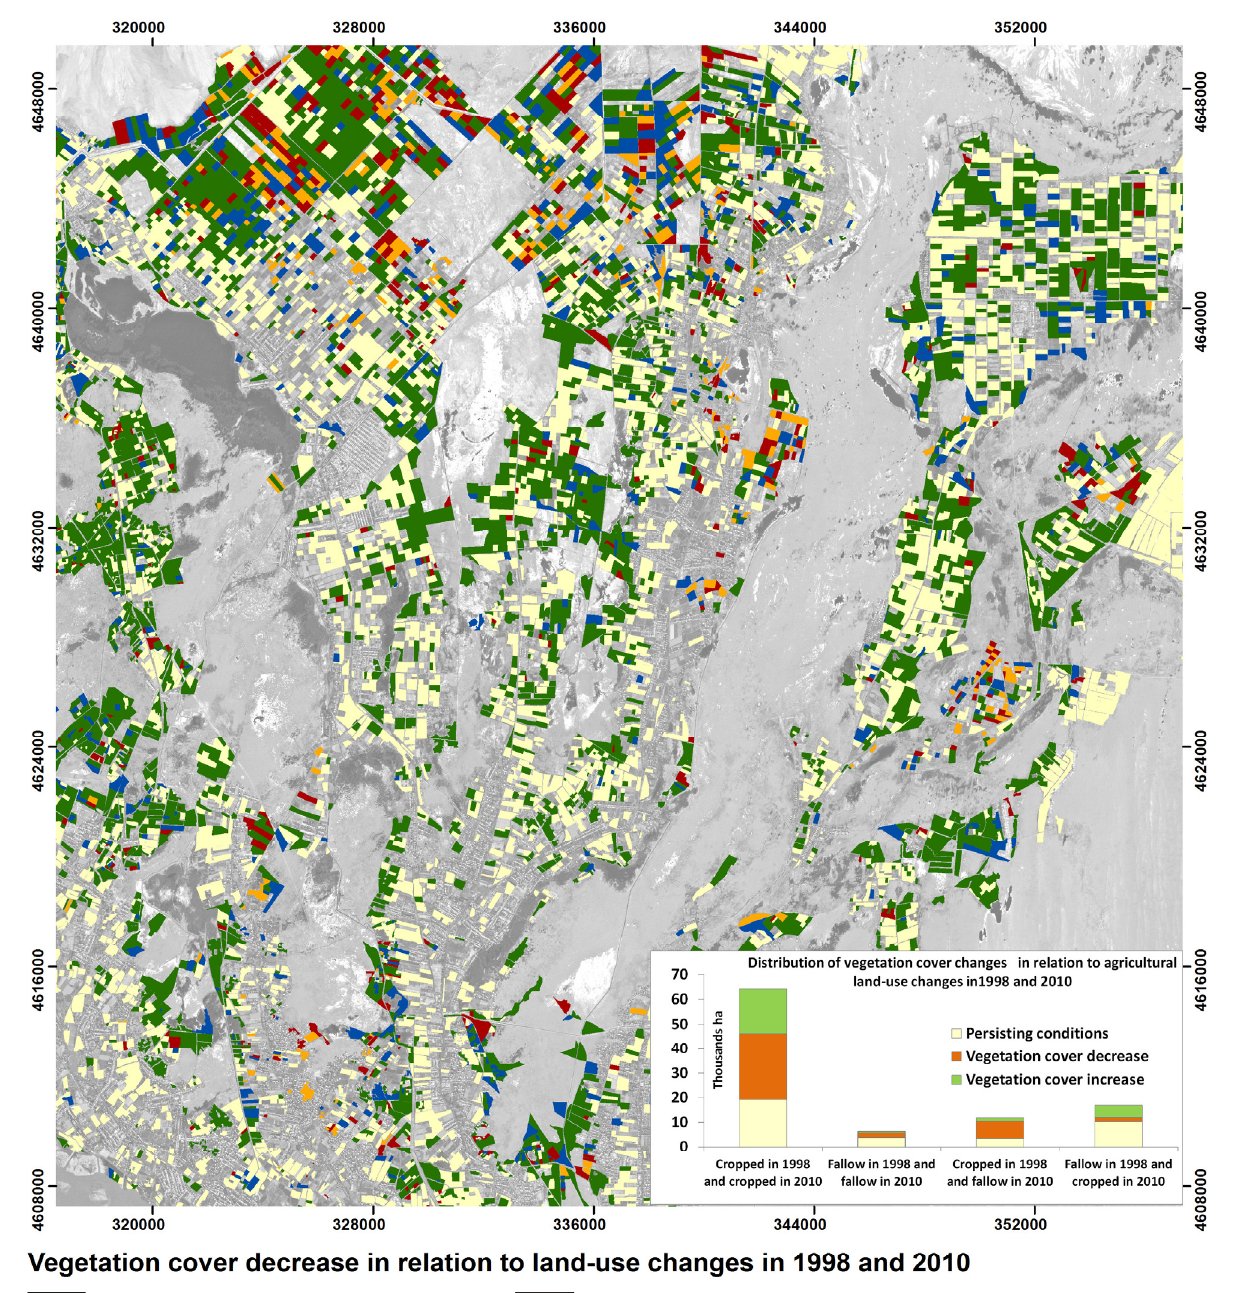
Figure 5. Spatial distribution of field parcels with decreased vegetation cover in relation to land-use changes between 1998 and